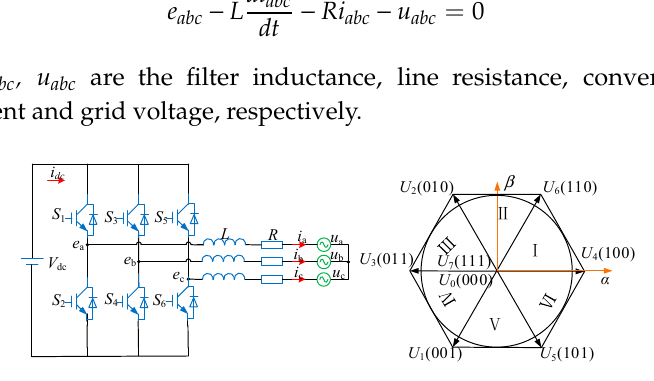
Figure 3. The topology and voltage vectors of a three-phase grid-connected converter.